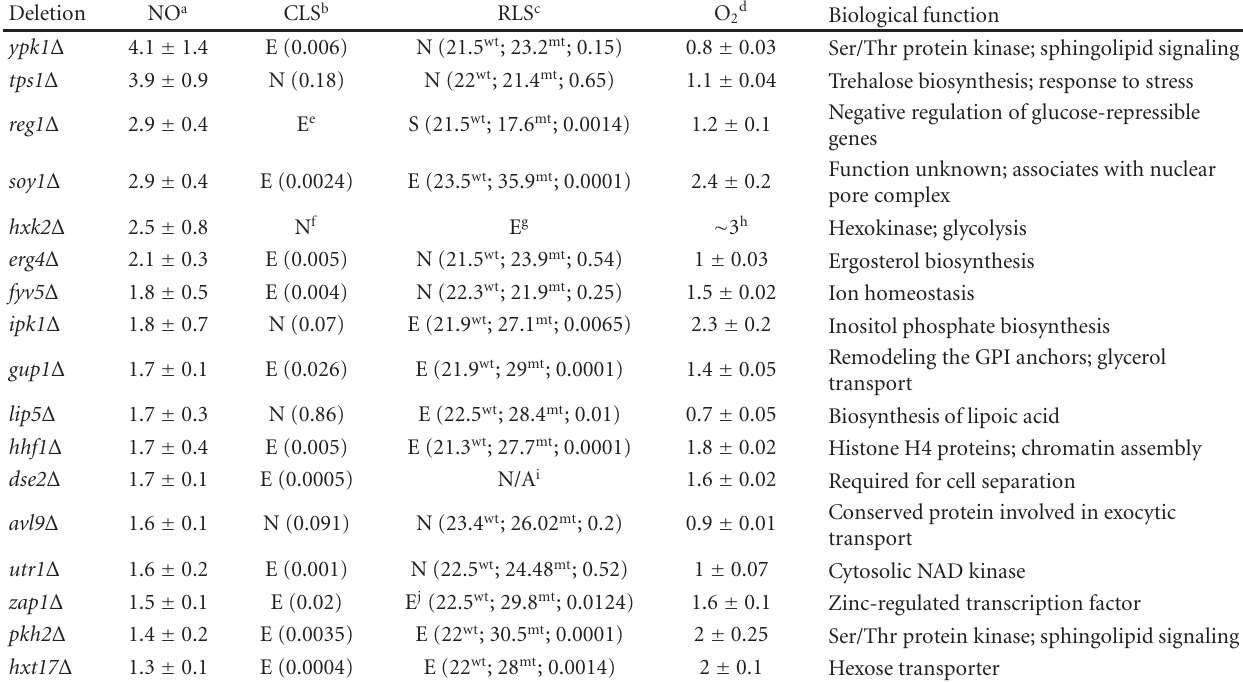
Table 1: List of potential genetic mimics of